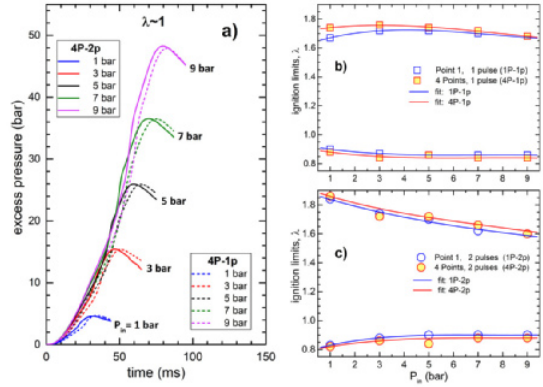
Fig. 2 a) Pressure vs. time for LI in four points of CH 4 -air stoichiometric b) a train of five pulses is shown. c) The combustion mixtures ( λ ~1) at various initial pressure, P in . Limits of ignition for λ , chamber is presented. considering ignition with a) a laser pulse and b) trains of two laser